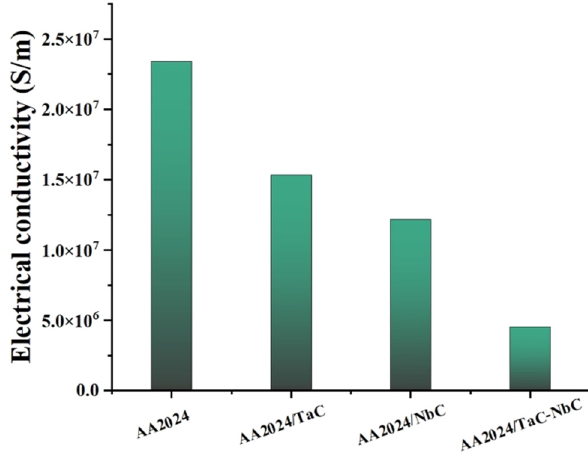
Figure 15: Microhardness of the samples as a function of arti fi cial aging time. Figure 16: Electrical conductivity of AA2024 and its